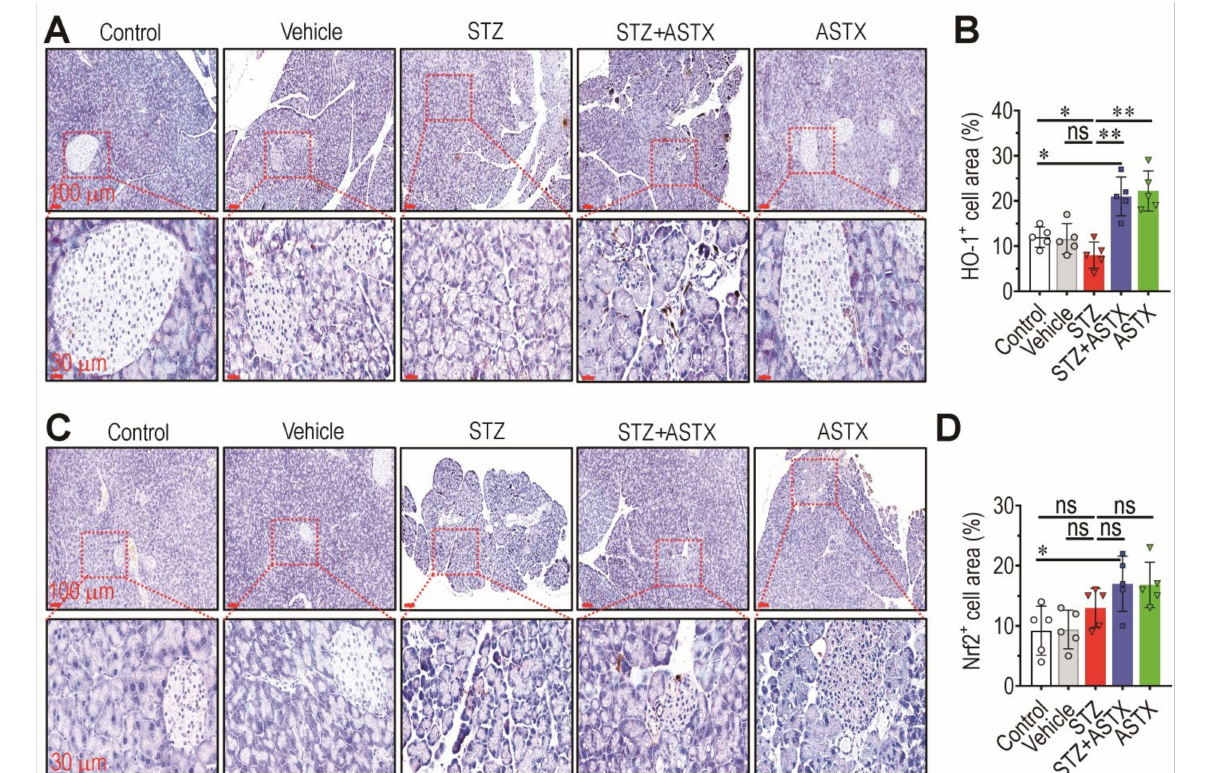
Figure 4. Oral supplementation with ASTX increases levels of HO-1 and Nrf2 in the pancreas of STZ-induced diabetic mice. Expression levels of ( A ) HO-1 and ( C ) Nrf2 in the pancreas of mouse groups were determined by IHC 60 days after hyperglycemia induction. The area (%) positively stained with ( B ) HO-1 or ( D ) Nrf2 was determined using ImageJ software ( n = 5/group). * p < 0.05 and ** p < 0.01 by unpaired Student’s t -test. ns, not